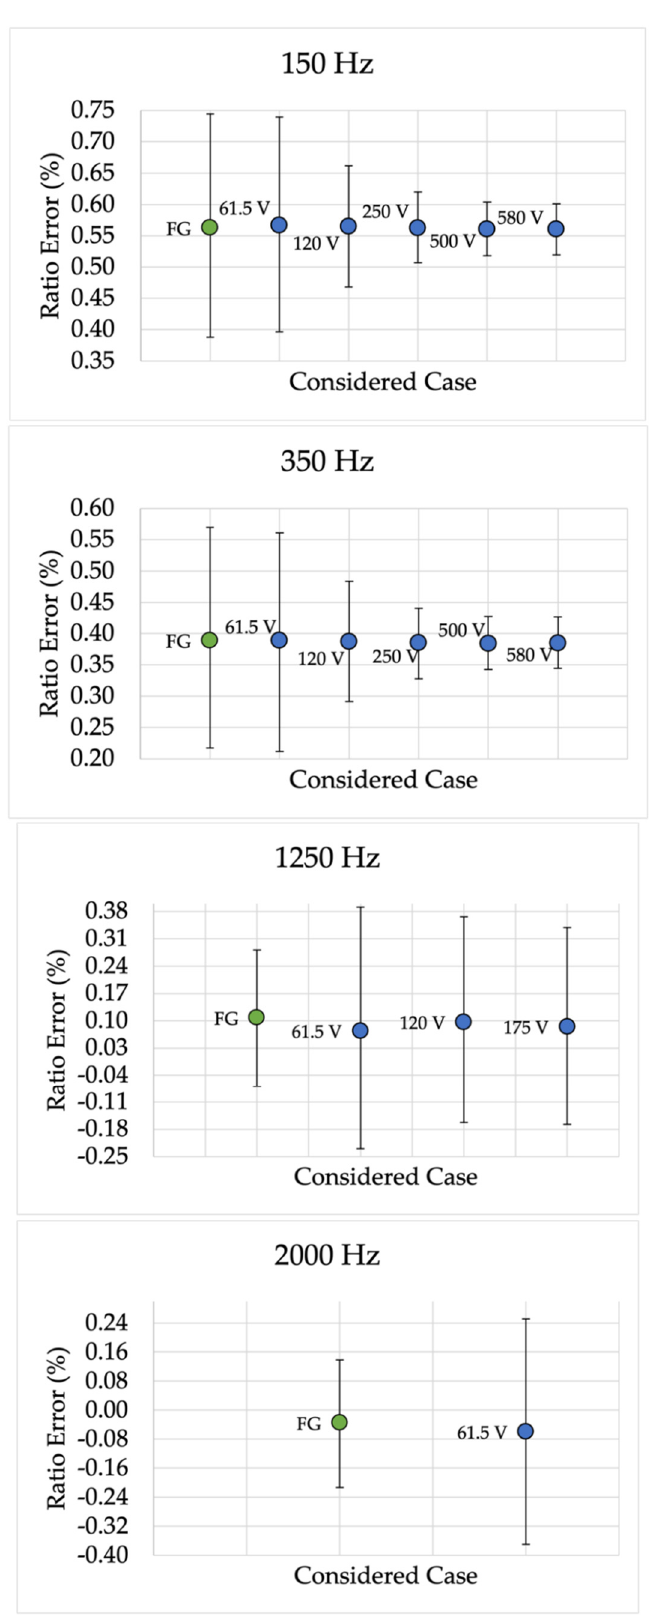
Figure 5. Ratio error 95% confidence intervals for different frequencies and for device A.